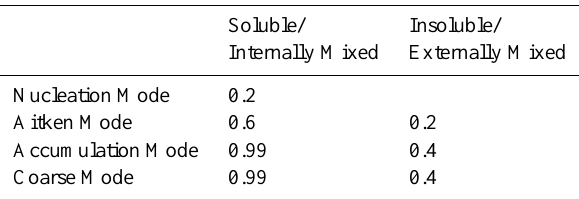
Table 2. Prescribed cloud-droplet-borne fractions as a function of aerosol mode implemented for the purposes of convective wet scav- enging and used for the simulation PF std. The same fractions are used for ice-crystal-borne